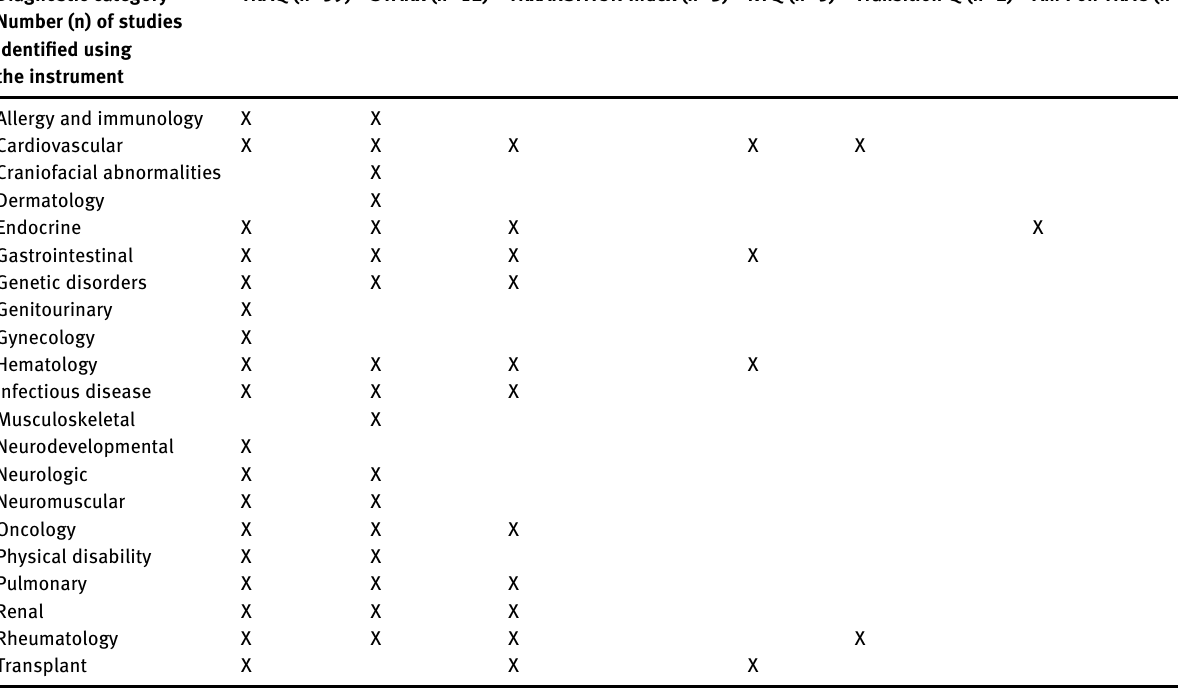
Table  : Diagnostic categories representing chronic illnesses in which transition readiness was measured. Diagnostic